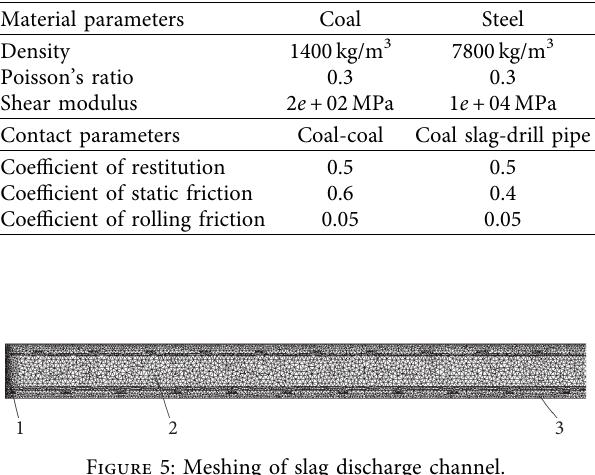
Table 2: Inlet boundary conditions. Table 3: Material parameters and contact parameters.